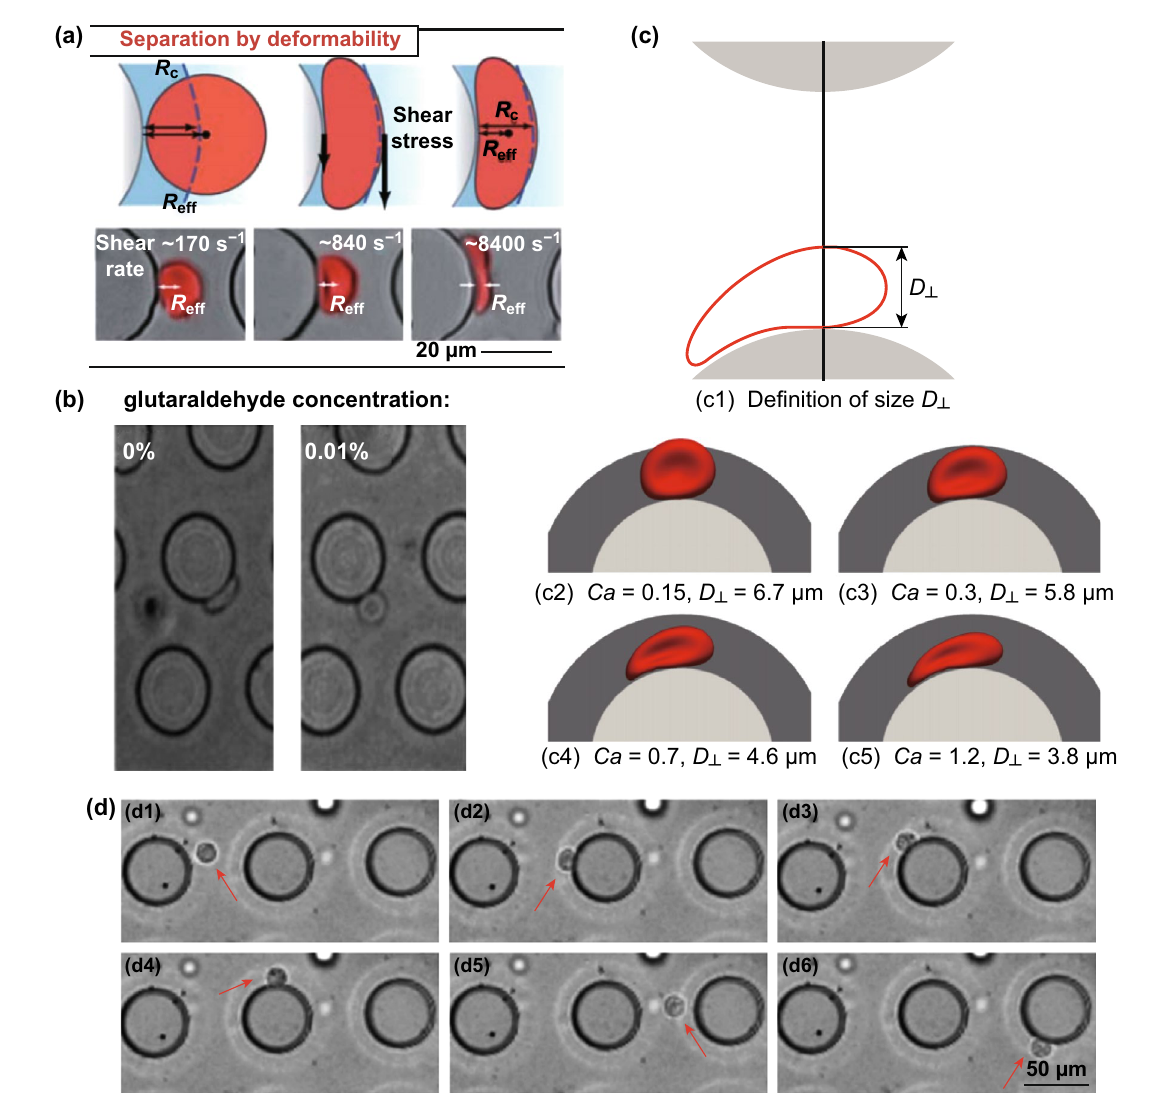
Fig. 13 Applications of deformability-based separation. a The influence of shear rates on the effective radius of RBCs separation in DLD [15]. b The simulation study with different capillary numbers and stiffnesses of red blood cells [91]. c The effect of glutaraldehyde on RBC stiffness and the separation in DLD [82]. d The application of high flow rate to induce the deformation on MG-63 cells that leads to the zigzag trajectory in DLD (red arrow, from the left to the right) [16]. Figure panels reproduced from Ref. [15] with permission from the Royal Society of Chemis- try, copyright 2012, Ref. [91] with permission from the AIP publishing, copyright 2014, Ref. [82] with permission from the Royal Society Pub- lishing (CC BY 2014), Ref. [16] with permission from the Royal Society of Chemistry, copyright